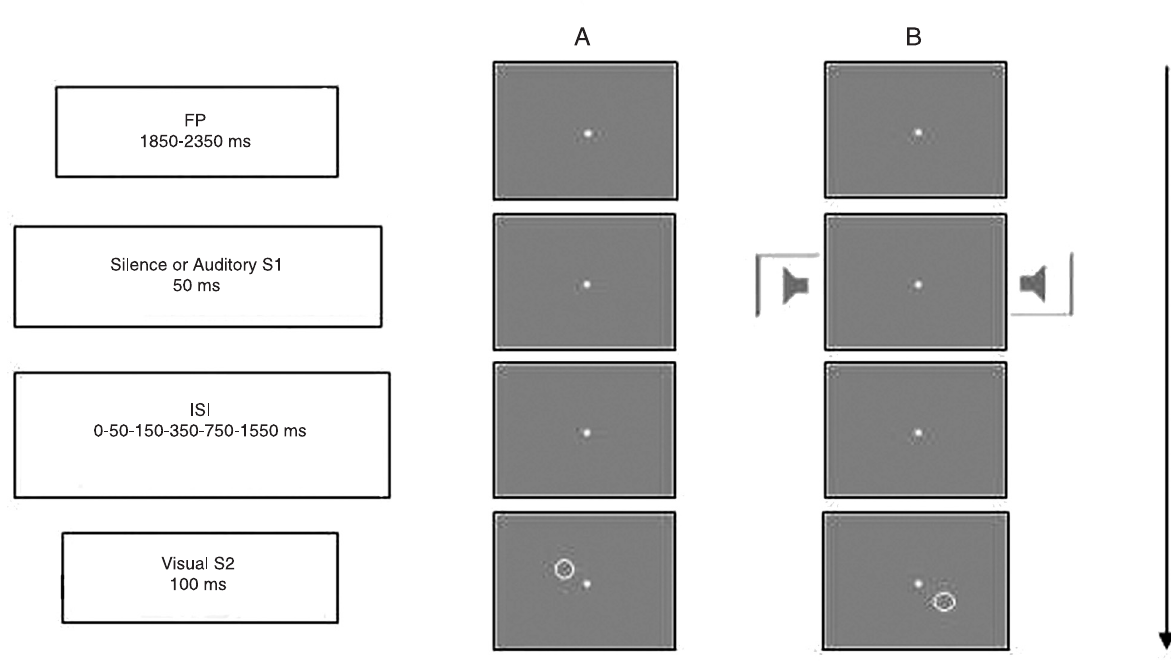
Figure 1. Schematic representation of the sequence of events in a warning stimulus absent trial (Panel A) and a warning stimulus present trial (Panel B). The warning stimulus (S1) was a 300-Hz 57-dB tone, which lasted 50 ms. The target stimuli (S2) were a circle (represented in Panel A) and an ellipse-like figure (represented in Panel B) 34 cd/m 2 bright, which lasted 100 ms. The stimulus onset asynchronies were 50, 100, 200, 400, 800, and 1600 ms (note that these values represent the duration of the S1 plus the duration of the inter-stimulus interval). The message screen, which appears for 400 ms at the end of the trial was not represented. FP = fixation point; ISI = inter-stimulus